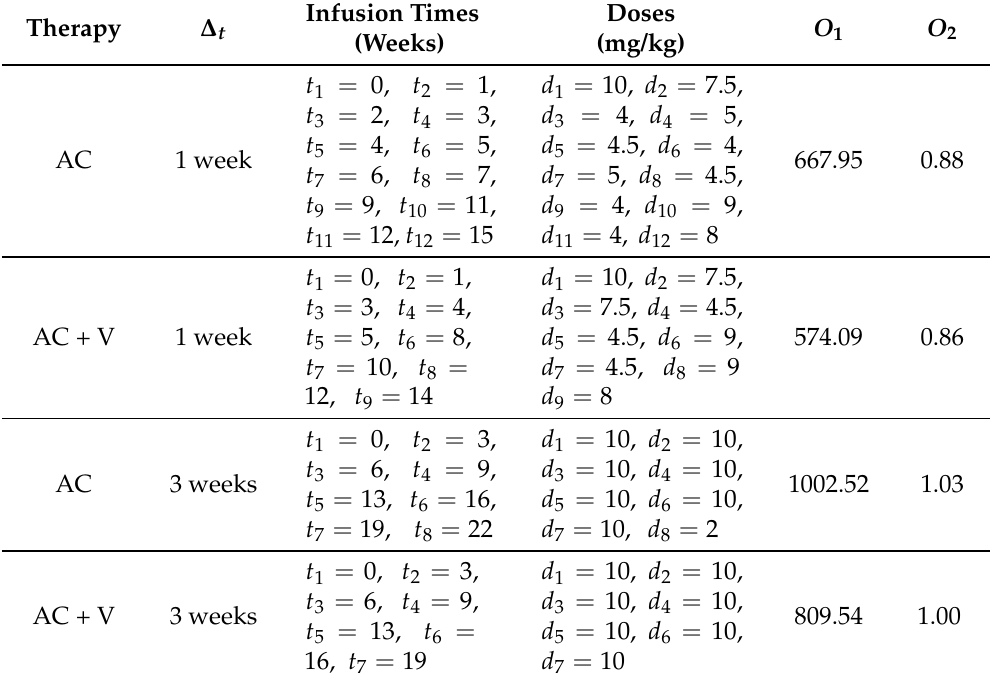
Table 6. Numerical results for the optimization problem OP2, with a halved value of k AC . Anti- CTLA4 has been administered as mono-therapy (AC) and in combination with dendritic cell vaccine (AC + V). Both the immunotherapies have been tested by taking into account the general constraints defined in Section 2.5 and an additional constraint concerning the minimum time interval between two infusions ( ∆ t ) fixed as 1 or 3 weeks. Column three and four list the infusion times and doses predicted by the model as the optimal schedules. The values O 1 and O 2 represent the first two components of the optimization function, namely O 1 =